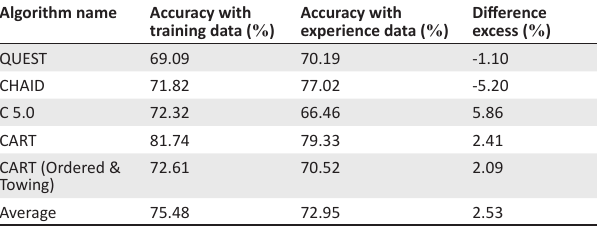
TABLE 6: Algorithms accuracy of 14 chosen trees. Algorithm name